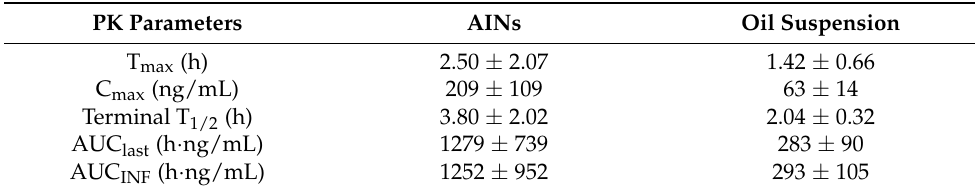
Table 1. Pharmacokinetic parameters after oral administration of AINs and an oil suspension in beagle dogs ( n =